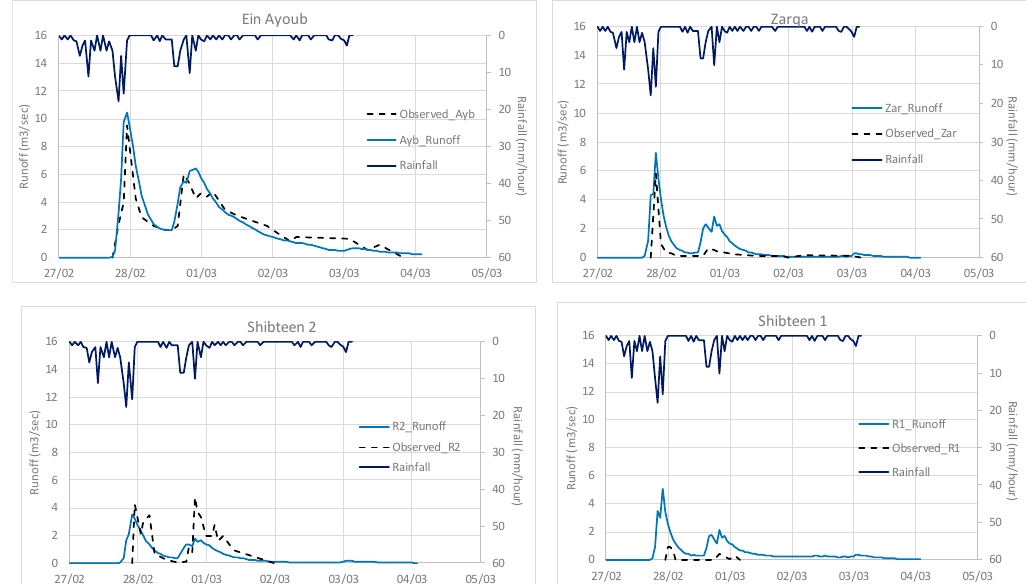
Figure 7. Comparison between the simulated and observed wadi flows at the four gauging stations (Figure 1): Ein Ayoub (Ayb), Shibteen 2 (R2), Wadi Zarqa (Zar), and Shibteen 1 (R1). Dates on X axis are formatted in day/month (dd/mm) for 2009.